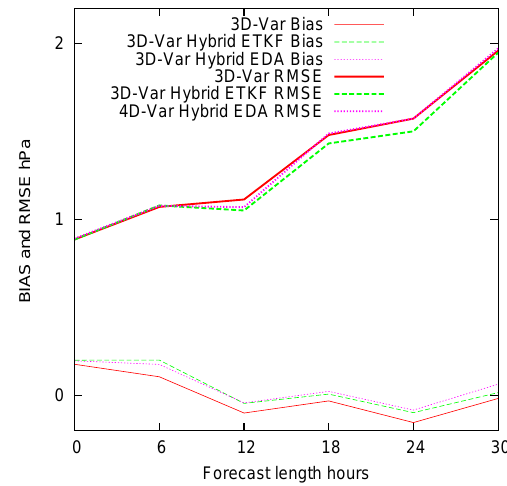
Fig. 14. Bias and standard deviation verification scores for mean sea level pressure forecasts over a Scandinavian domain averaged over the period 19 January–29 February 2008 and given as func- tions of forecast length. The control forecast from the 3D-Var (red full curve), the 3D-Var hybrid based on the ETKF ensemble (green dashed curve) and the 3D-Var hybrid based on the EDA ensemble (pink dotted curve) experiments are included. Forecasts have been run with 12th hourly lateral boundary conditions.